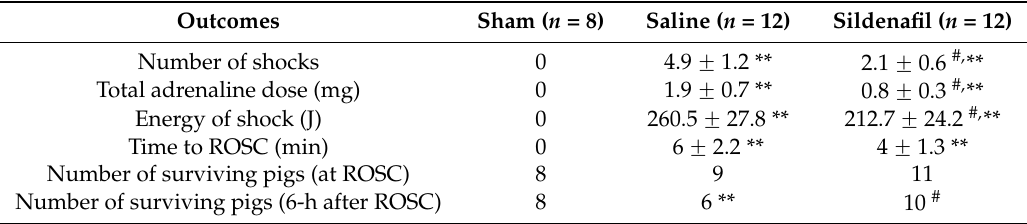
Table 1. Outcome measures after post-resuscitation in sham, saline, and sildenafil-treated groups in a porcine myocardial ischemia/reperfusion (I/R) injury